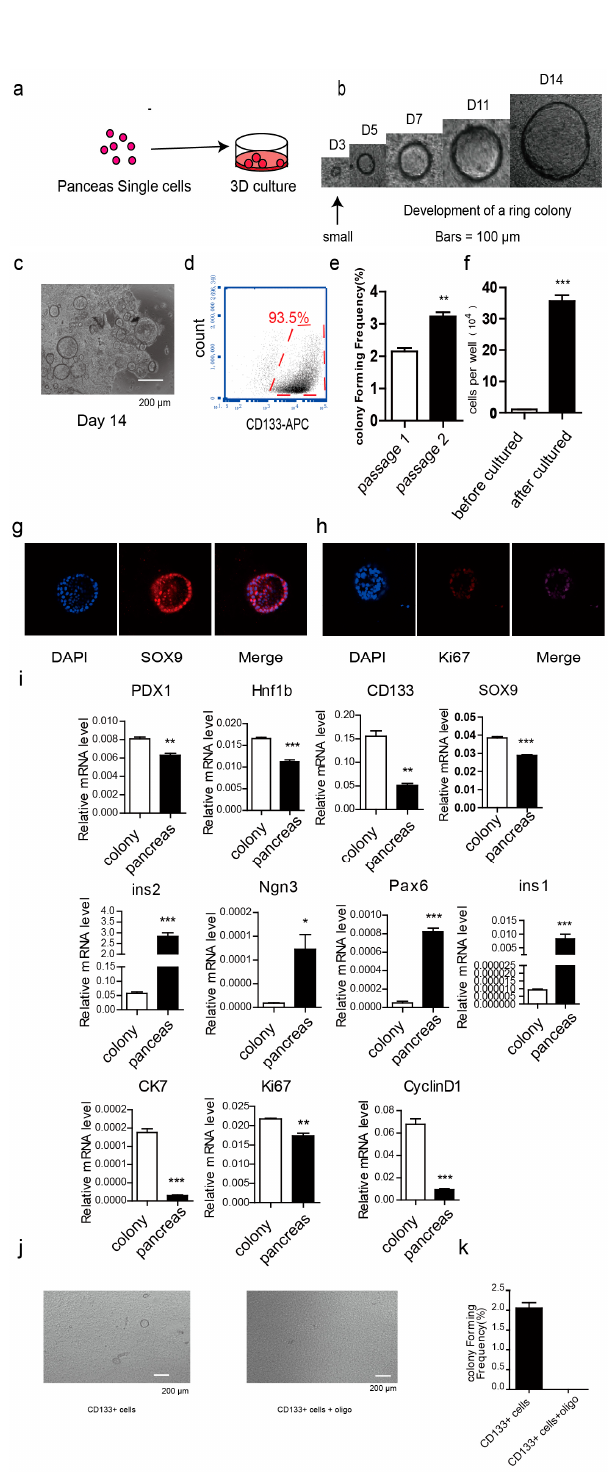
Figure A2. Significantly changed genes enriched in different KEGG pathways (represented by p - values) in progenitor-like cells cultured in vitro, compared to pancreatic single cells. Each column represents the mRNA level of the tricarboxylic acid cycle-related enzymes. As shown, all of the tricarboxylic acid cycle-related enzymes are up-regulated in progenitor-like cells.